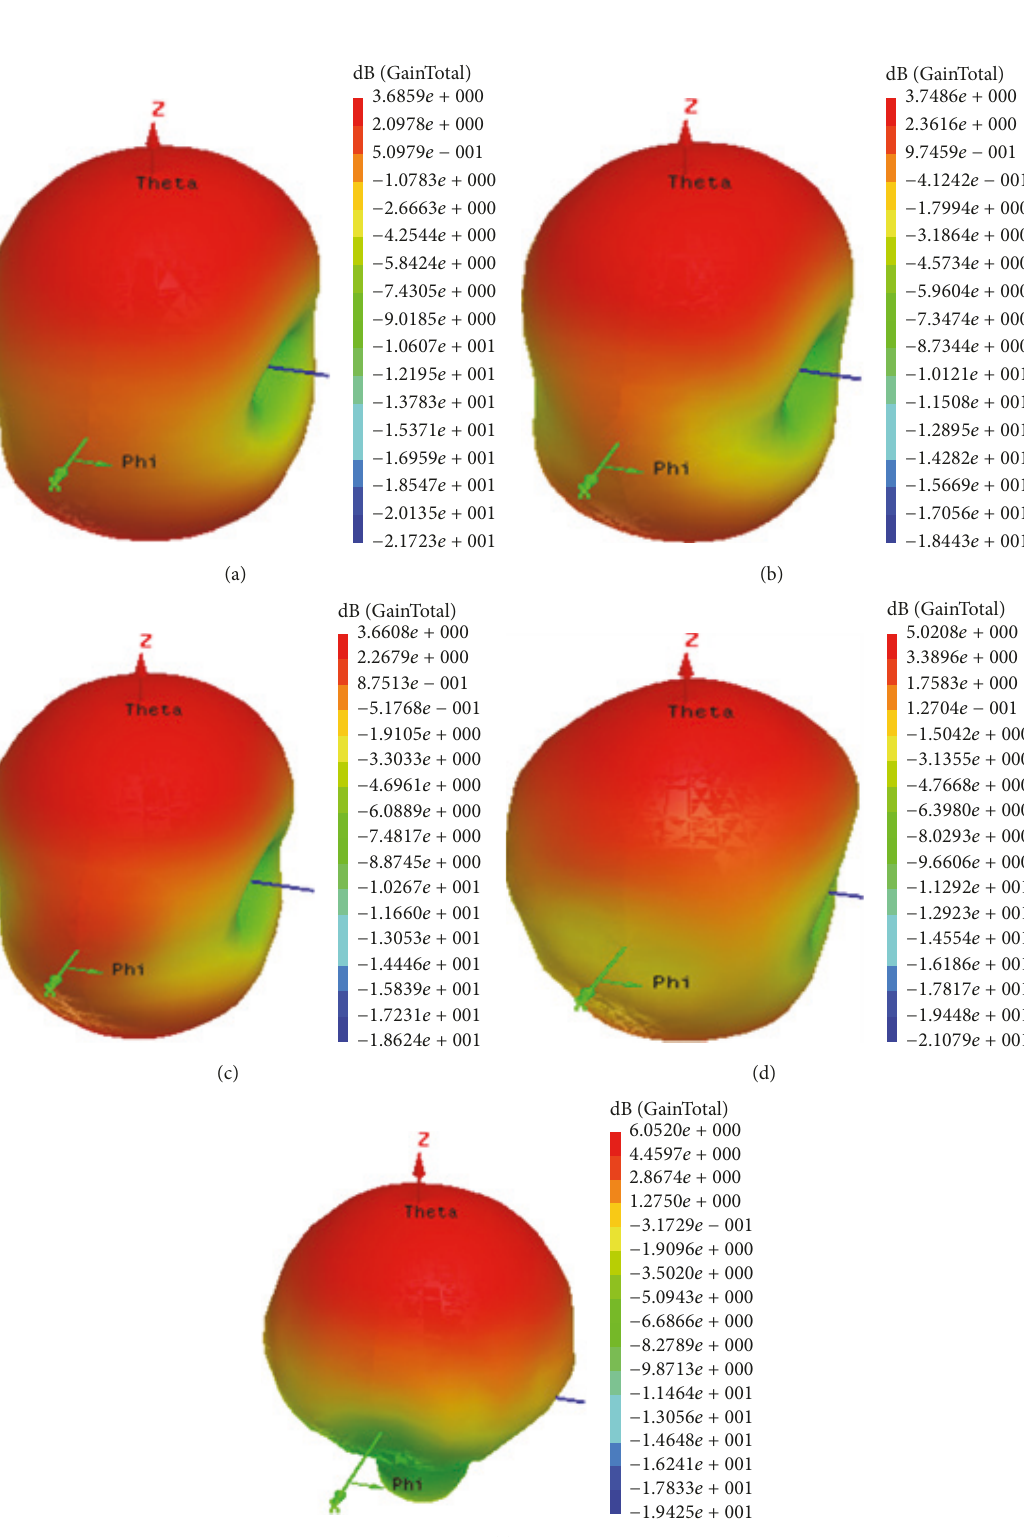
Figure 13: 3D gain plot for the five configurations. (a) Config-I, (b) Config-II, (c) Config-III, (d) Config-IV, and (e)